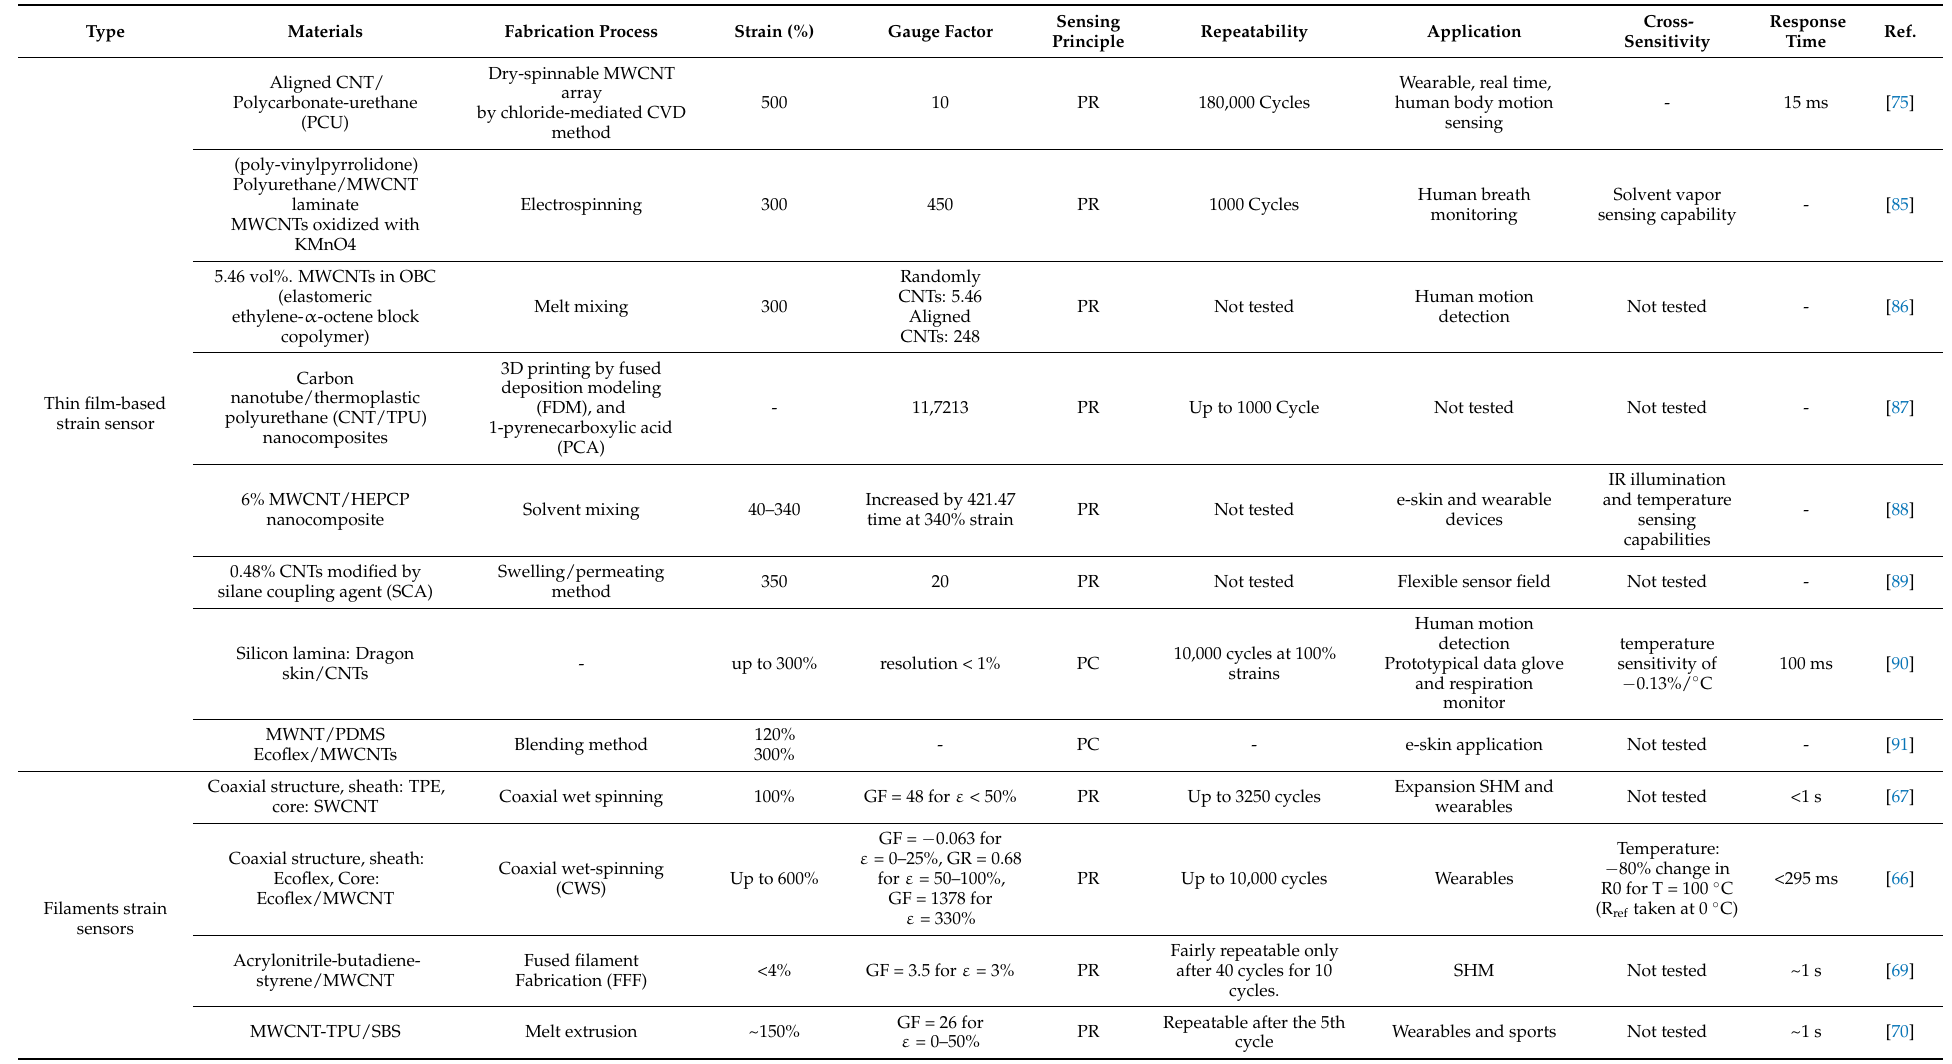
Table 2. Flexible and stretchable polymer/CNTs strain sensors performances, PR: piezoresistive, PC: